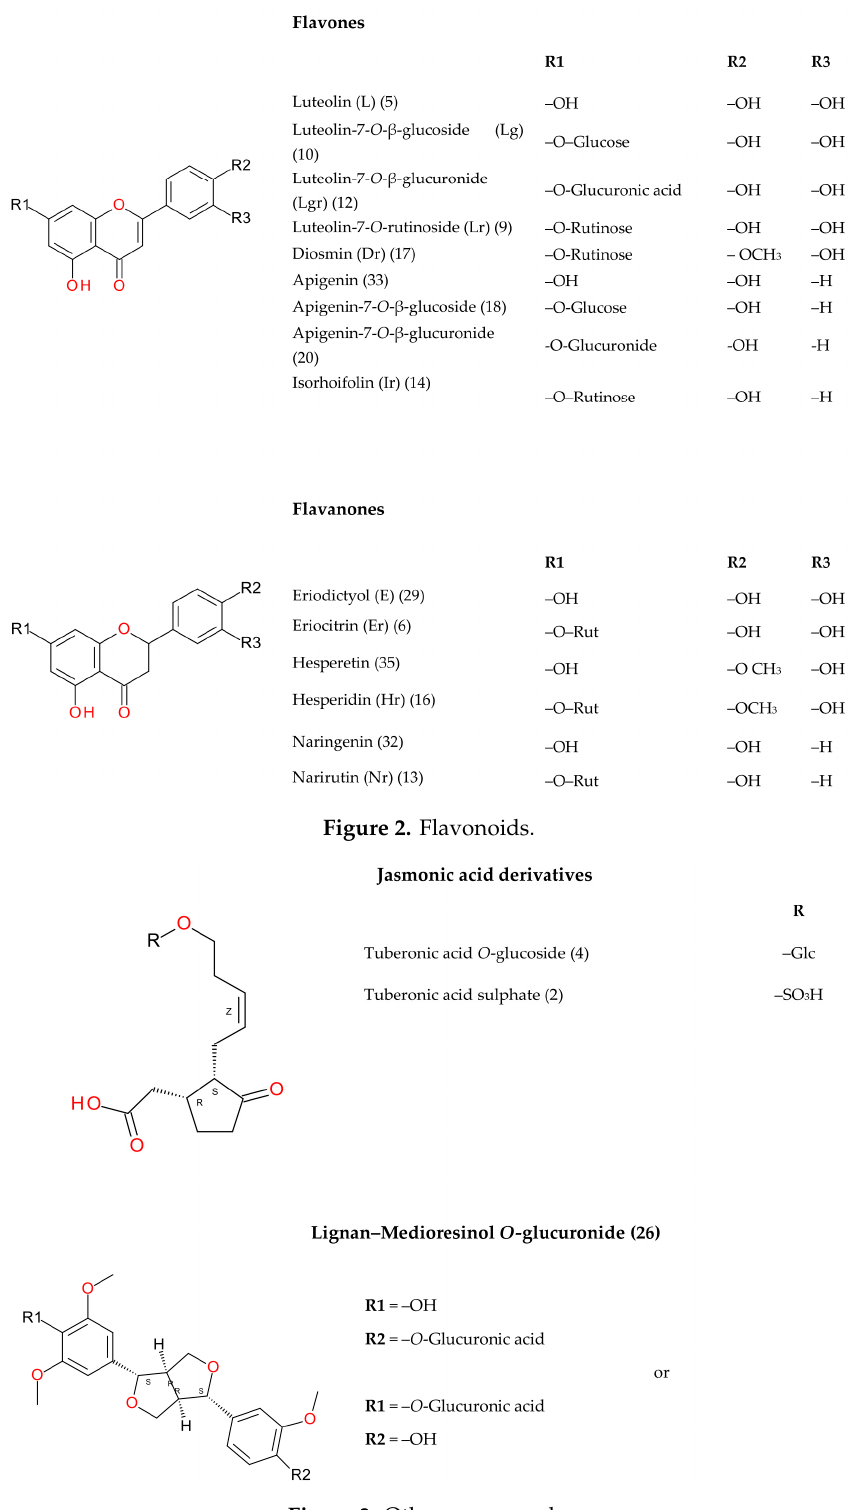
Figure 3. Other Figure 3. Other compounds.